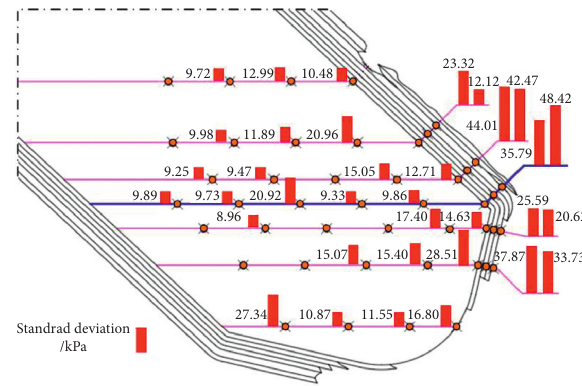
Figure 4: Standard deviation distribution of fluctuating